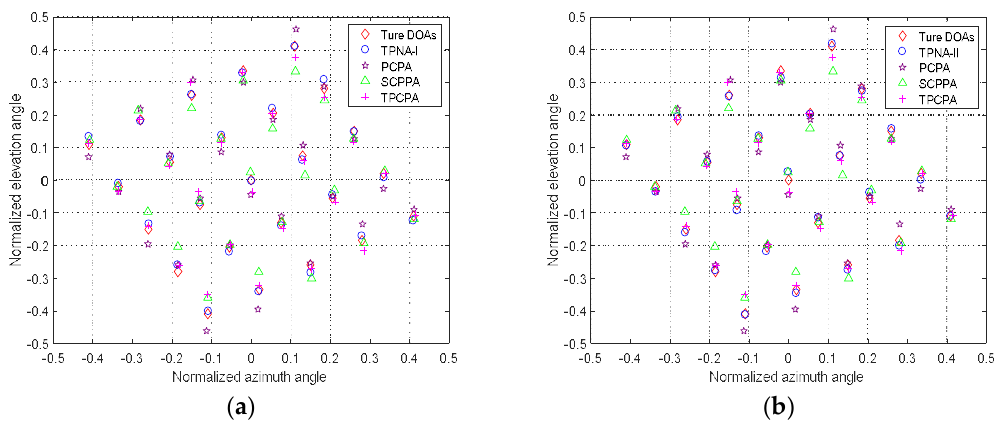
Figure 5. 2-D DOA estimation results comparison, where T = 500 and SNR = 0dB. ( a ) 2-D DOA estimation results of the proposed TPNAs-I and that of other three methods; ( b ) 2-D DOA estimation results of the proposed TPNAs-II and that of other three methods.